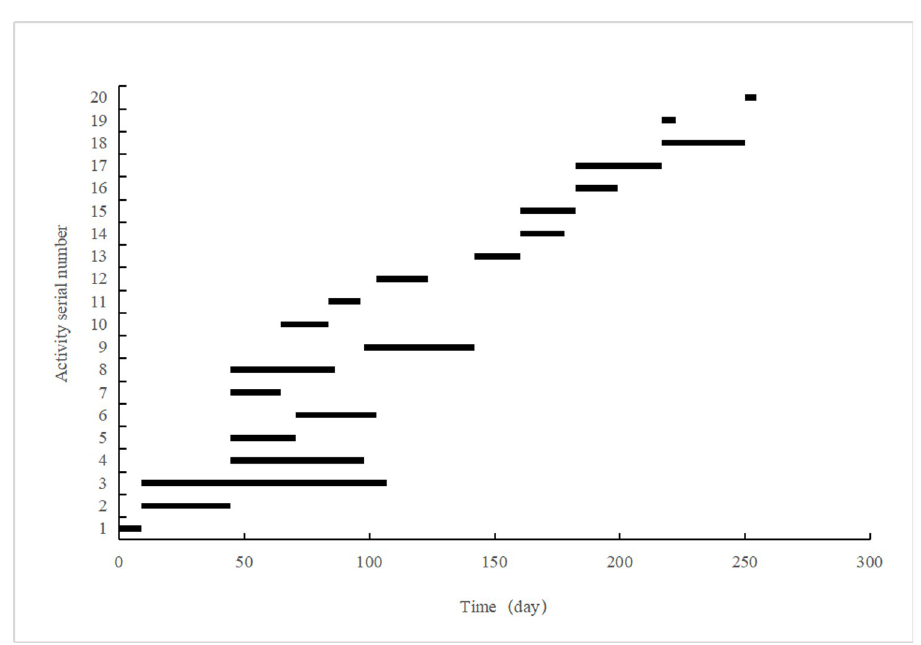
Fig 5. Bar chart of project schedule.